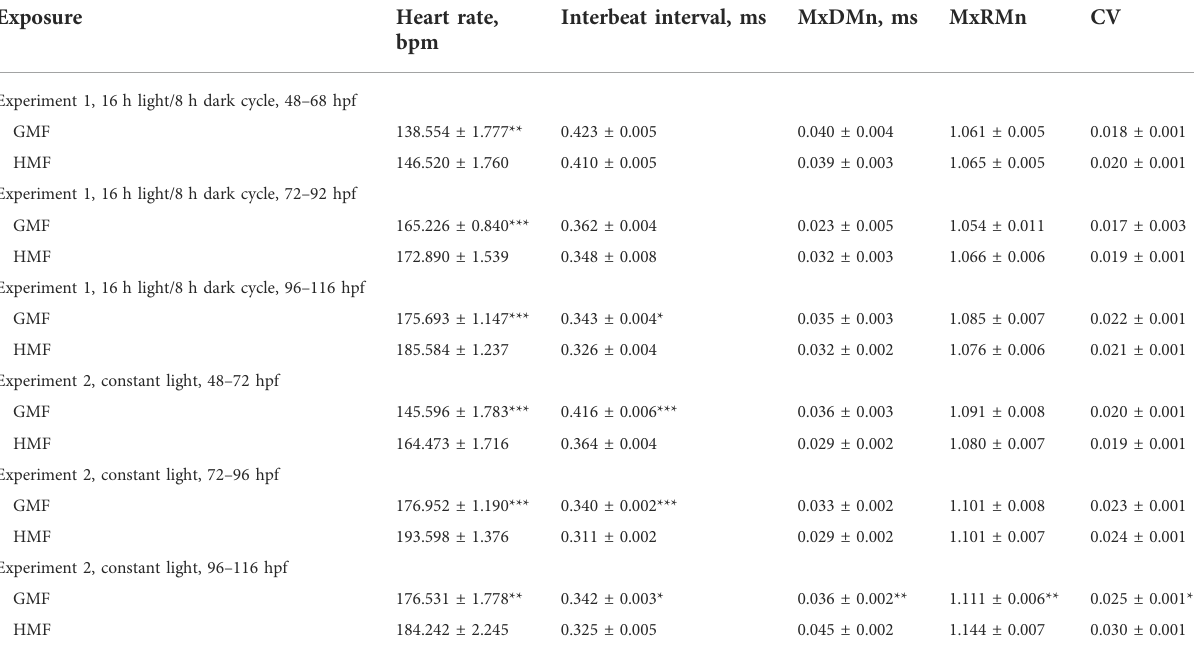
TABLE 1 Parameters of cardiac activity in zebra fi sh exposed to hypomagnetic fi eld (HMF) and geomagnetic fi eld (GMF) under different light conditions. Data are given as mean ± standard error ( n = 48, sum of the measurements registered within six time points for the 48 – 68 hpf, 72 – 92 hpf, and 96 – 116 hpf periods). Signi fi cant differences between groups exposed to HMF and GMF are indicated with asterisks (* p < 0.05; ** p < 0.01; *** p <